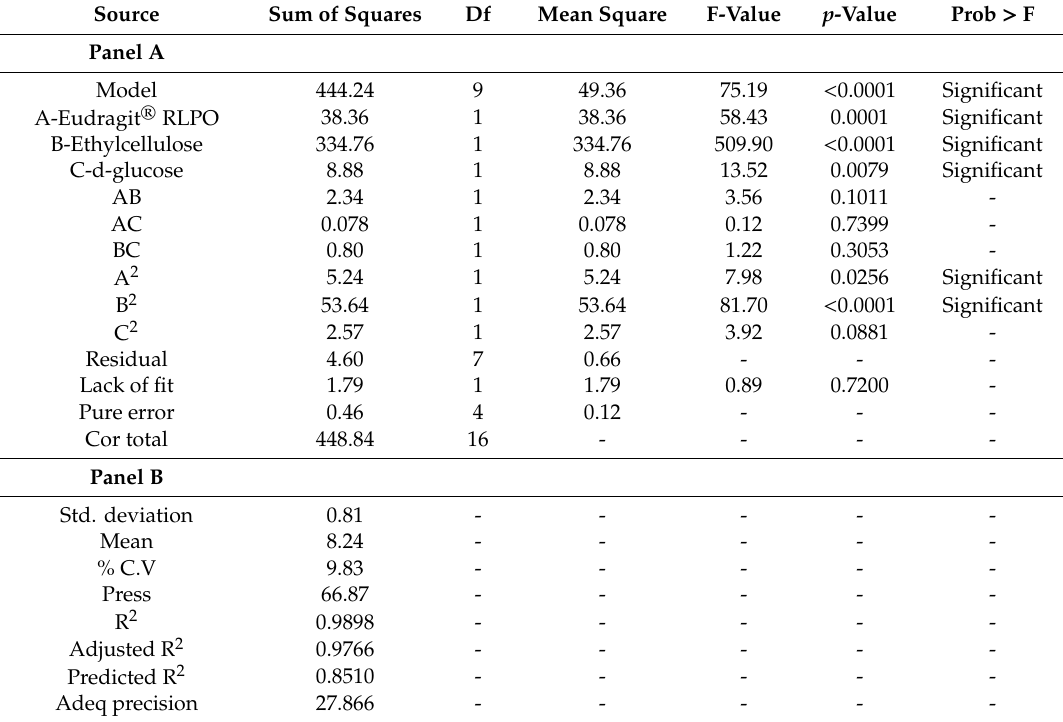
Table 9. ANOVA data for response surface quadratic model (partial sum of squares—Type III) for % RIF released at 0.5 h.